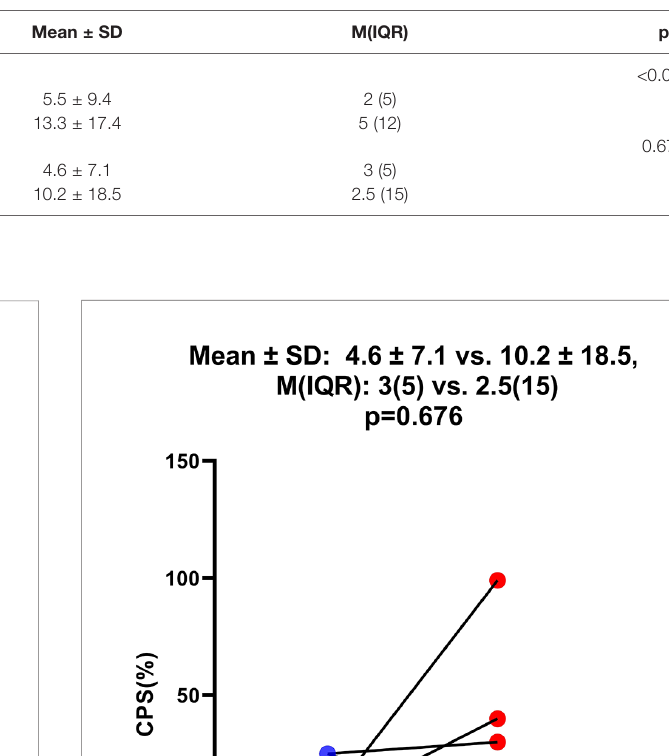
TABLE 1 | The CPS of gastric cancer test by tissue from gastric mucosa biopsy and postoperative pathology, primary gastric cancer and metastatic sites.